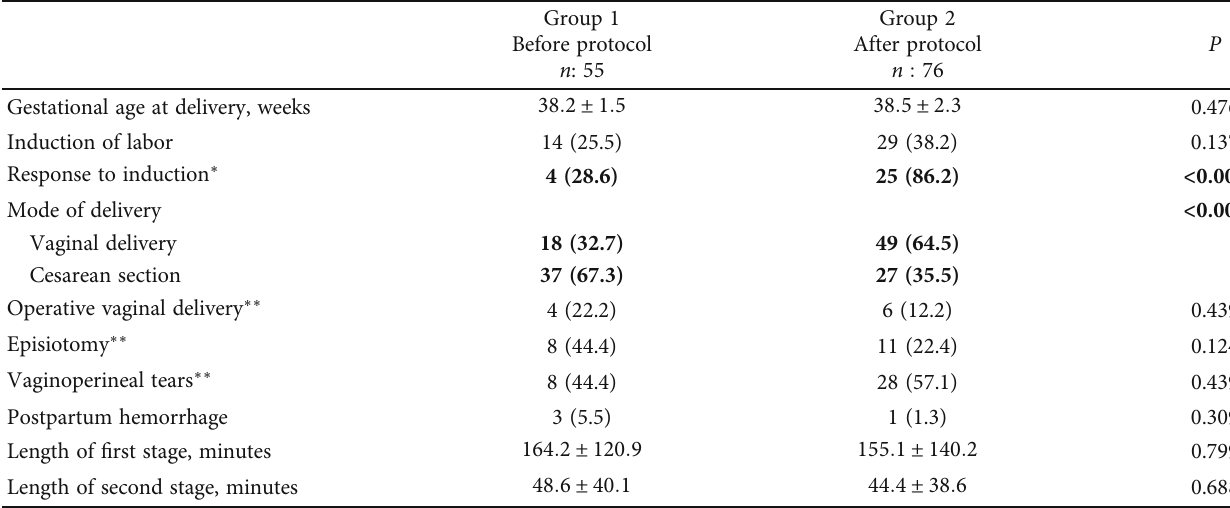
Table 3: Maternal outcomes of women with diabetes in pregnancy who delivered before (group 1) and after (group 2) the introduction of a standardized multidisciplinary management